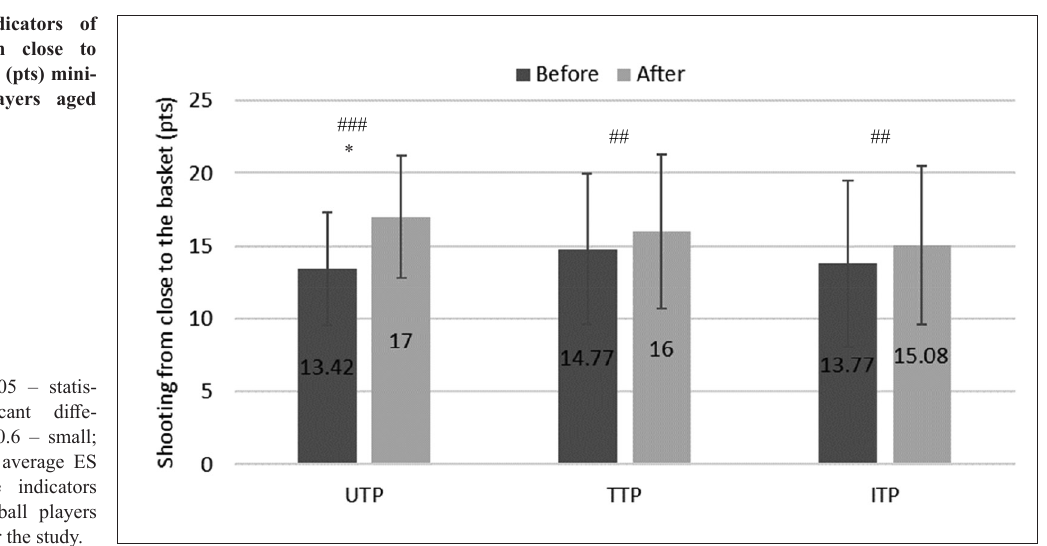
Figure 8. Indicators